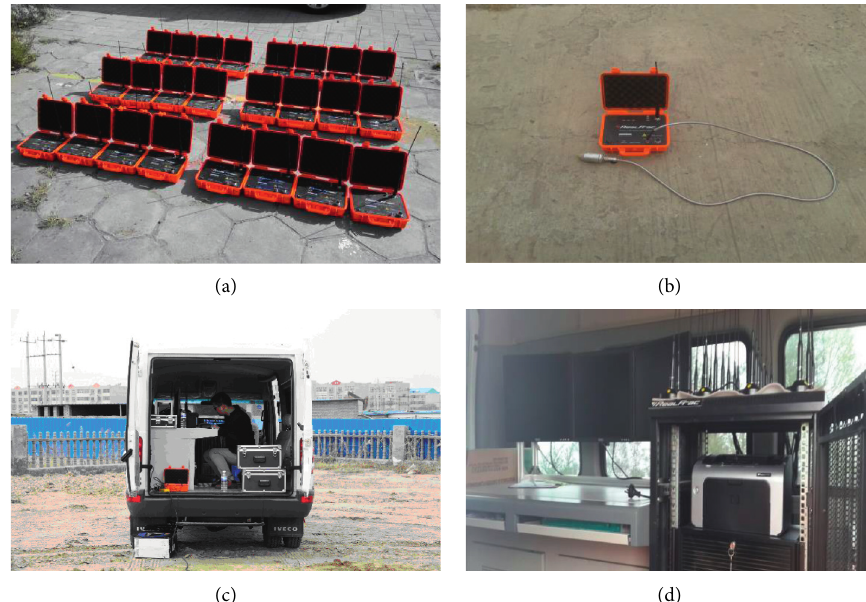
Figure 10: Microseismic monitoring equipment. (a) Monitoring station. (b) Detector. (c) Instrument car. (d) Interior of the instrument car.